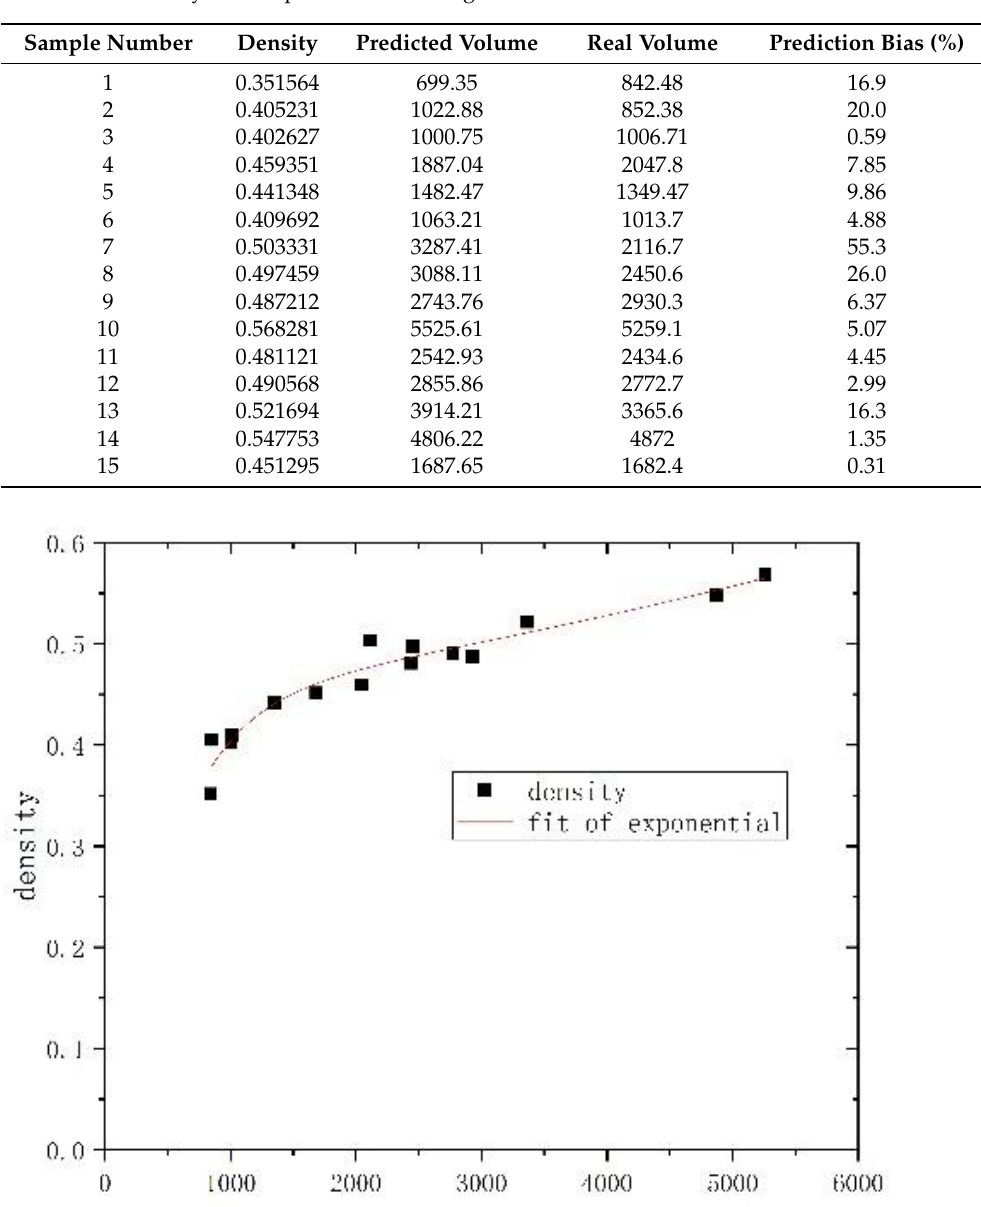
Table 1. Selected crystal samples for CIR testing.